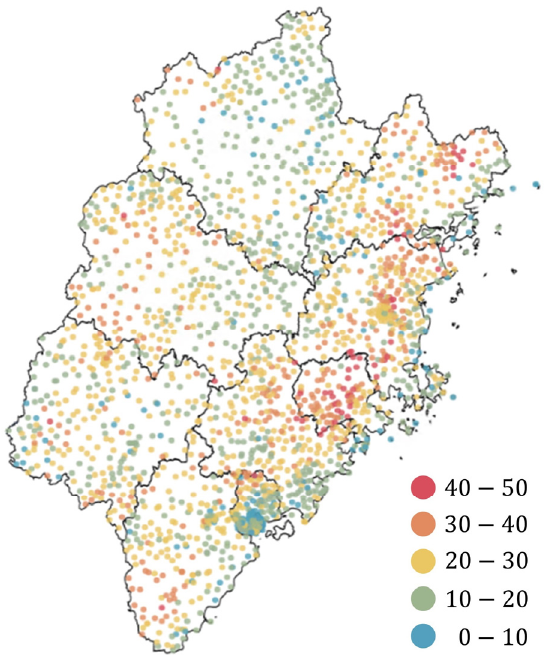
Figure 1. Distribution of each ground station in Fujian Province. The colors indicate the total number of observed short-term intensive rainfall events in February 2015 to December 2018 for each station [1]. The four original datasets issued by the Fujian Meteorological Observatory were used in this study (see Table 1 for details); the grid points refer to a series of nodes arranged in rows (latitude) and columns (longitude). These datasets can be divided into three categories. Table 1. Details of the original datasets.